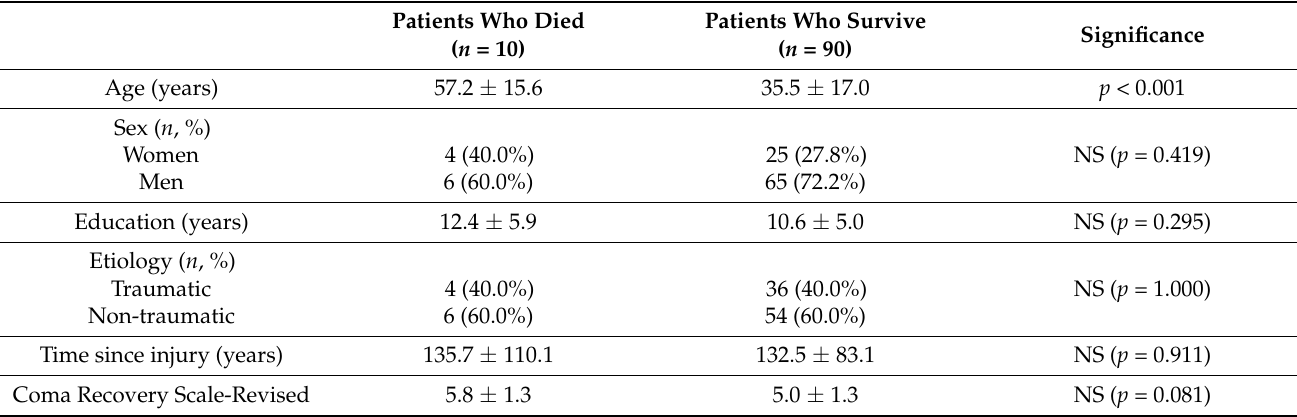
Table 6. Baseline demographic and clinical characteristics of the patients who did and did not emerge from Minimally Conscious State.